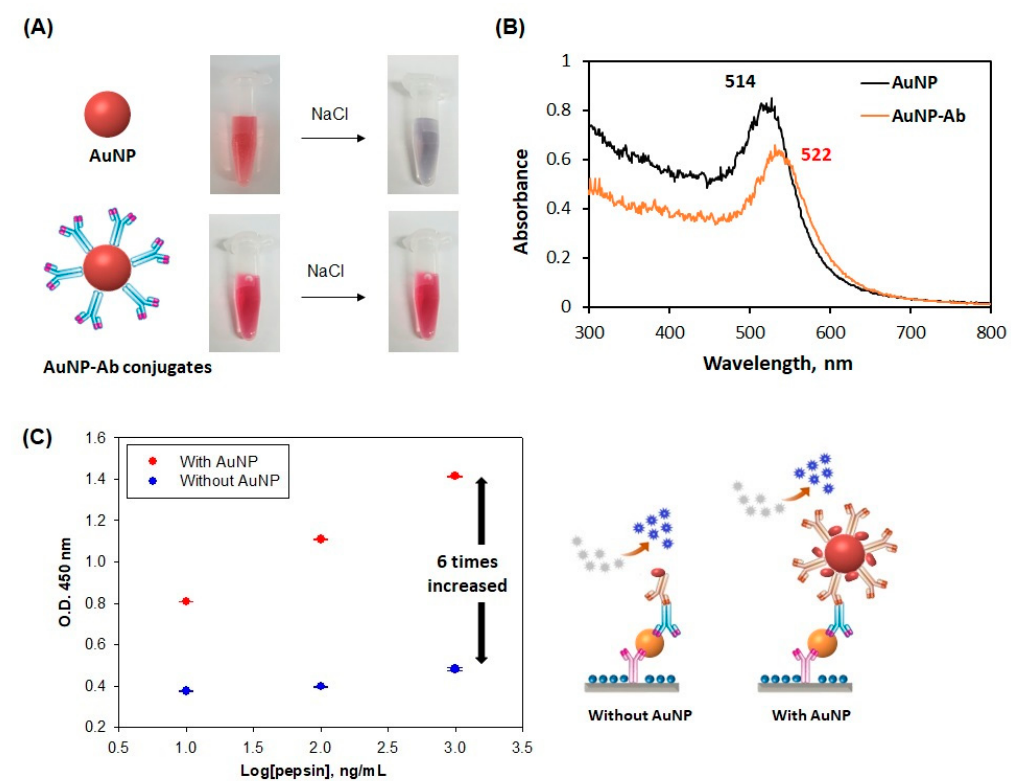
Figure 4. Evaluation of the optical performance of the gold nanoparticle (AuNP)-antibody conjugates. ( A ) Shows the stability of conjugates even after saltification; ( B ) shows the UV-Vis spectra of before and after the formation of conjugates, and ( C ) shows the result of the sandwich-type enzyme-linked immunosorbent assay (ELISA).